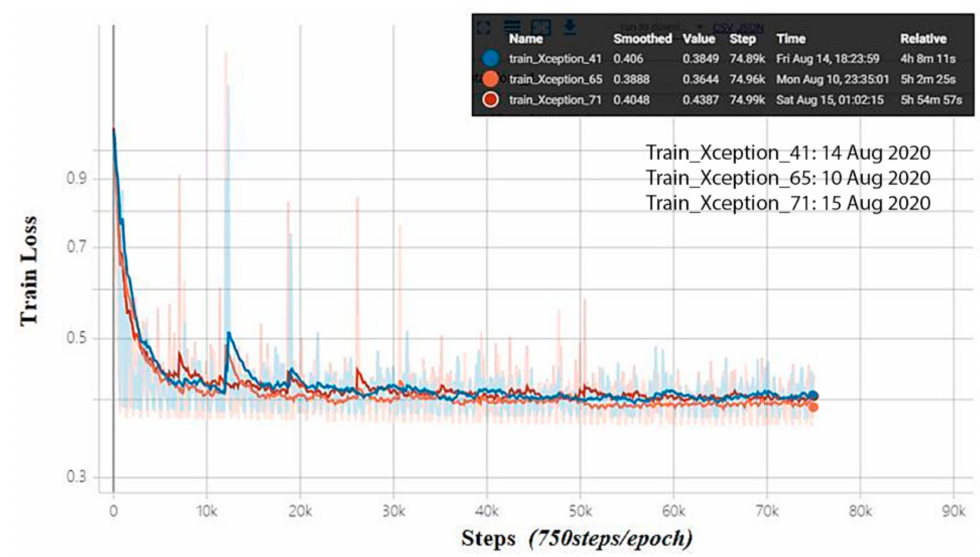
Figure 9. The training loss of Xception_71 during training. For validation, the already-trained three models that serve as the encoder’s backbone are successively used to predict the validation dataset containing 100 crack images and 50 background images (Table 2). The predicted crack images and non-crack images are shown in Figure 10. As shown in Figure 10a, the input image (left) is a 227 × 227 pixels raw image, the segmentation map (middle) is the predicted image with red pixels repre- senting crack pixels, and the segmentation overlay (right) is the overlay of raw image and translucent segmentation map. There are no red pixels in Figure 10b, just as there are no crack pixels in the raw image.